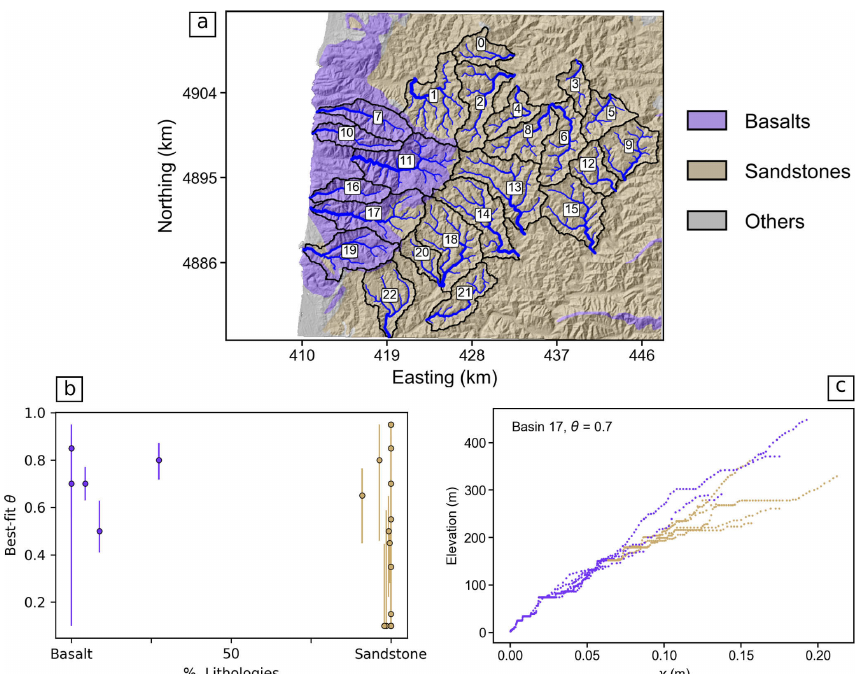
Figure 10. Exploration of the most likely concavity index near Waldport, Oregon, UTM zone 10N. Basin numbers and the underlying lithology is displayed in panel (a) . The most likely concavity index determined by the bootstrap method as a function of the percent of each basin in the different lithologies is shown in panel (b) . Panel (c) shows the χ –elevation plot for a basin that has two bedrock types; the channel pixels are coloured by lithology. The plot uses the typical concavity index for basalt (0.7).